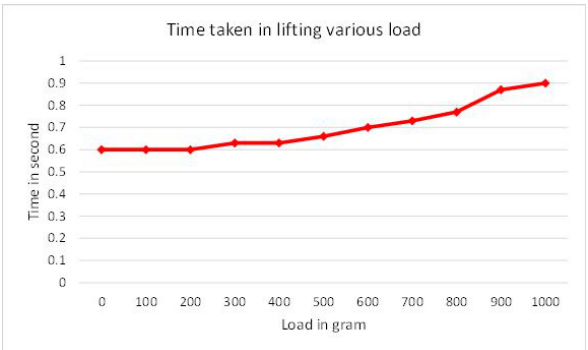
Figure 16: Graph of control load test